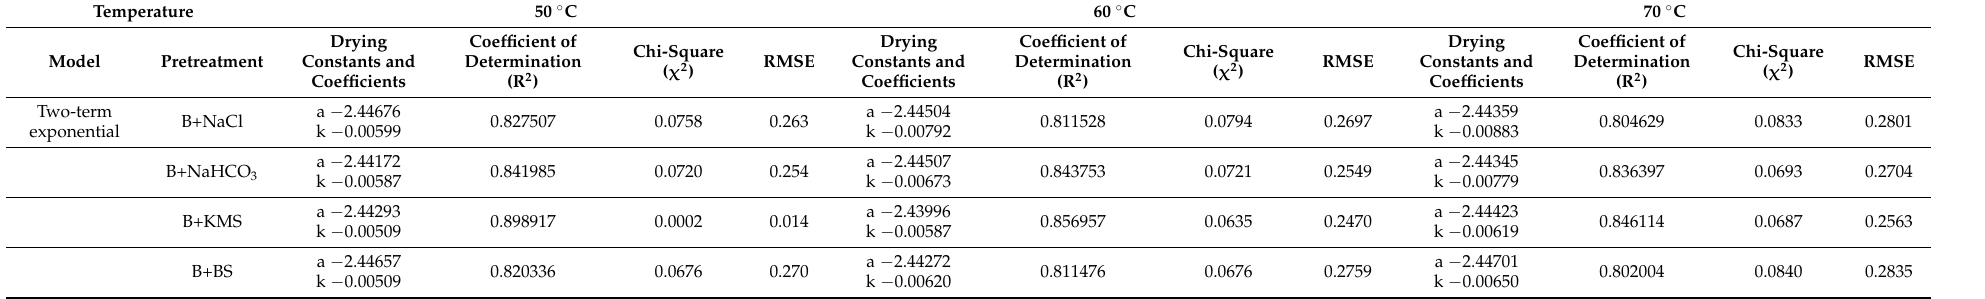
Table 4. Statistical analysis of different thin layer drying models of Moringa leaves under fluidized bed